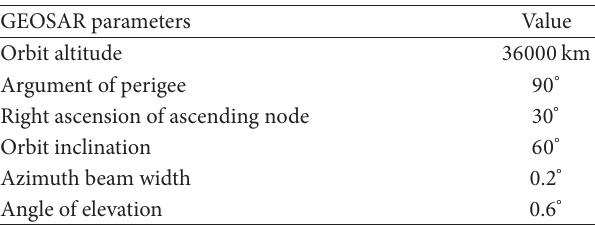
Table 1: GEOSAR transmitter parameters.